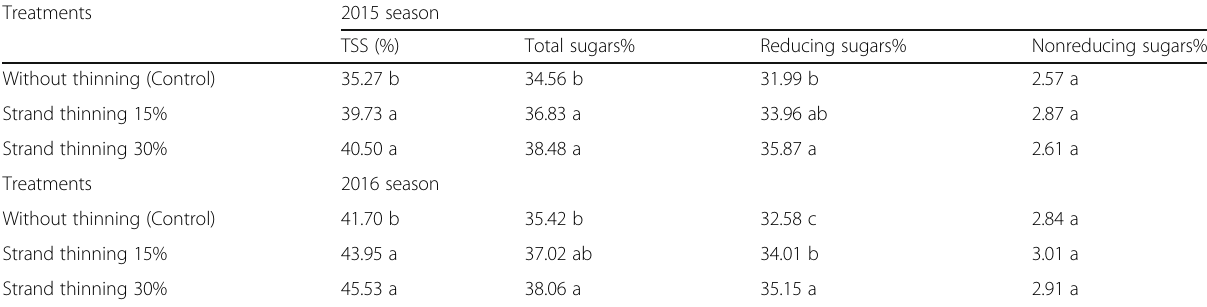
Table 4 Effect of strand thinning treatments on fruit TSS%, total sugars%, reducing sugars % and nonreducing sugars % of Khadrawi date palm cultivar at rutab stage during 2015 and 2016 seasons